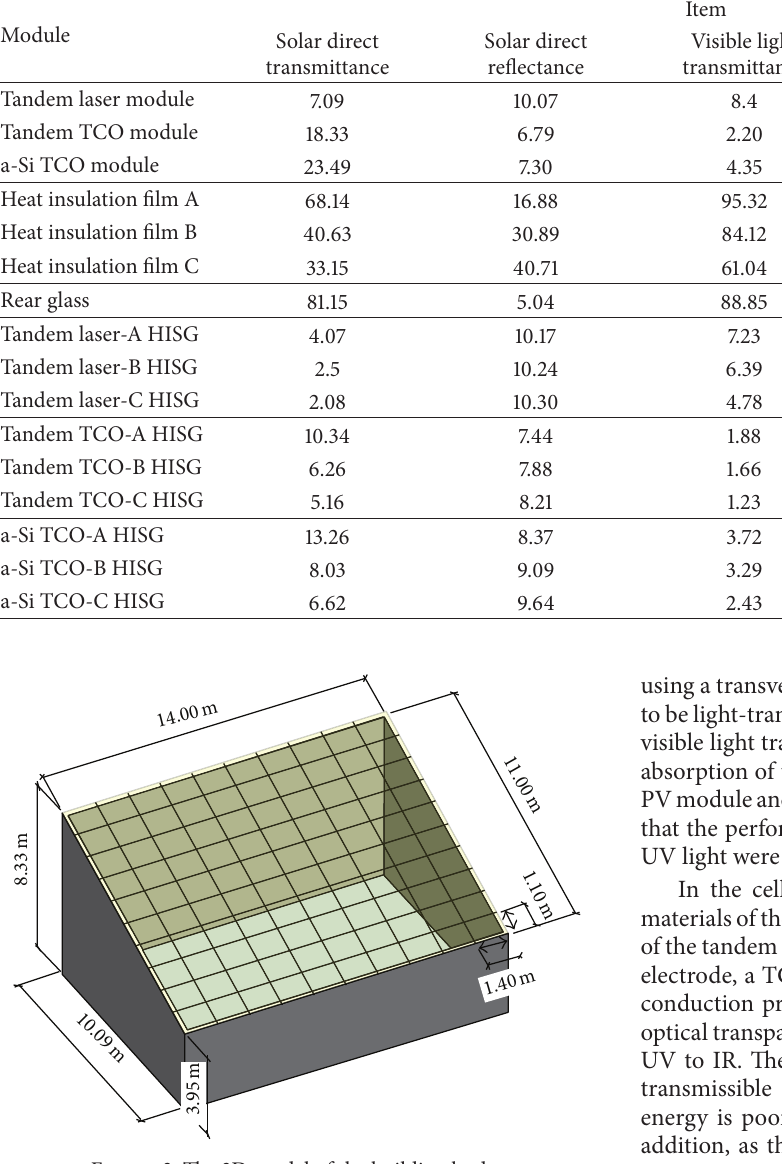
Figure 3: The 3D model of the building